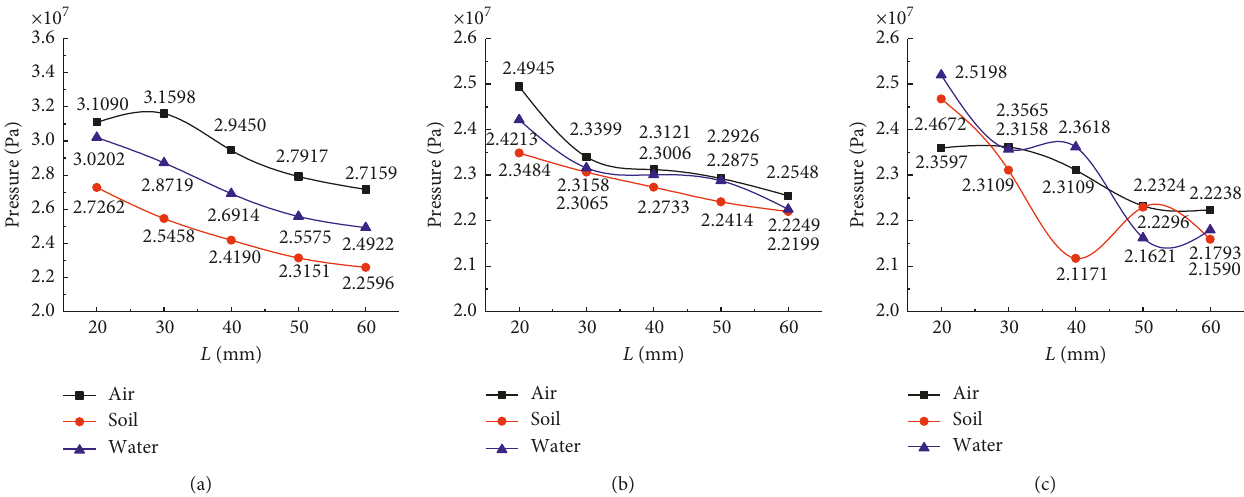
Figure 21: Relationship between fillings and pressure (all pressures are absolute values, but in fact, the pressure values are negative in (b) and (c)). (a) θ � 0 ° ; (b) θ � 45 ° ; (c) θ � 90 ° .